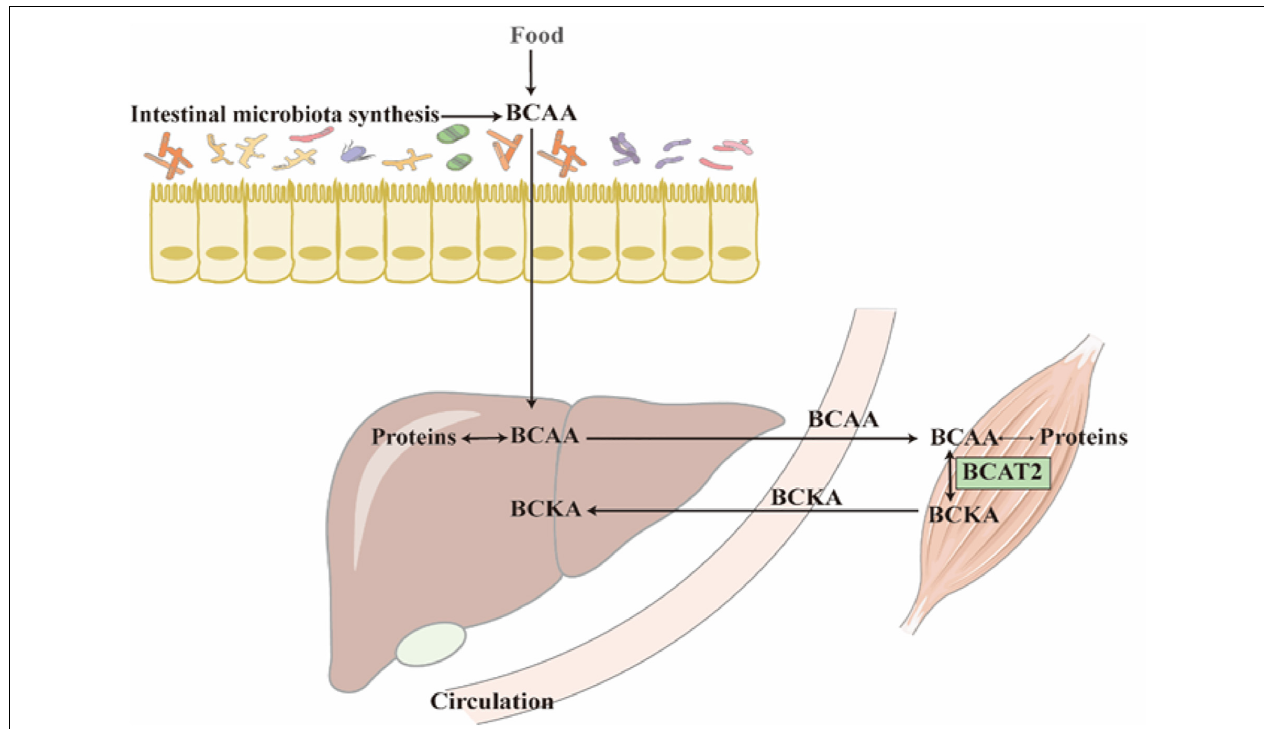
FIGURE 1 | Most of the BCAAs come from protein decomposition and food absorption. The reversible transamination reaction of BCAAs catabolism mostly occurs in skeletal muscle. After BCKAs are released back into circulation, most of them are oxidatively decarboxylated to acyl-CoA in the liver.